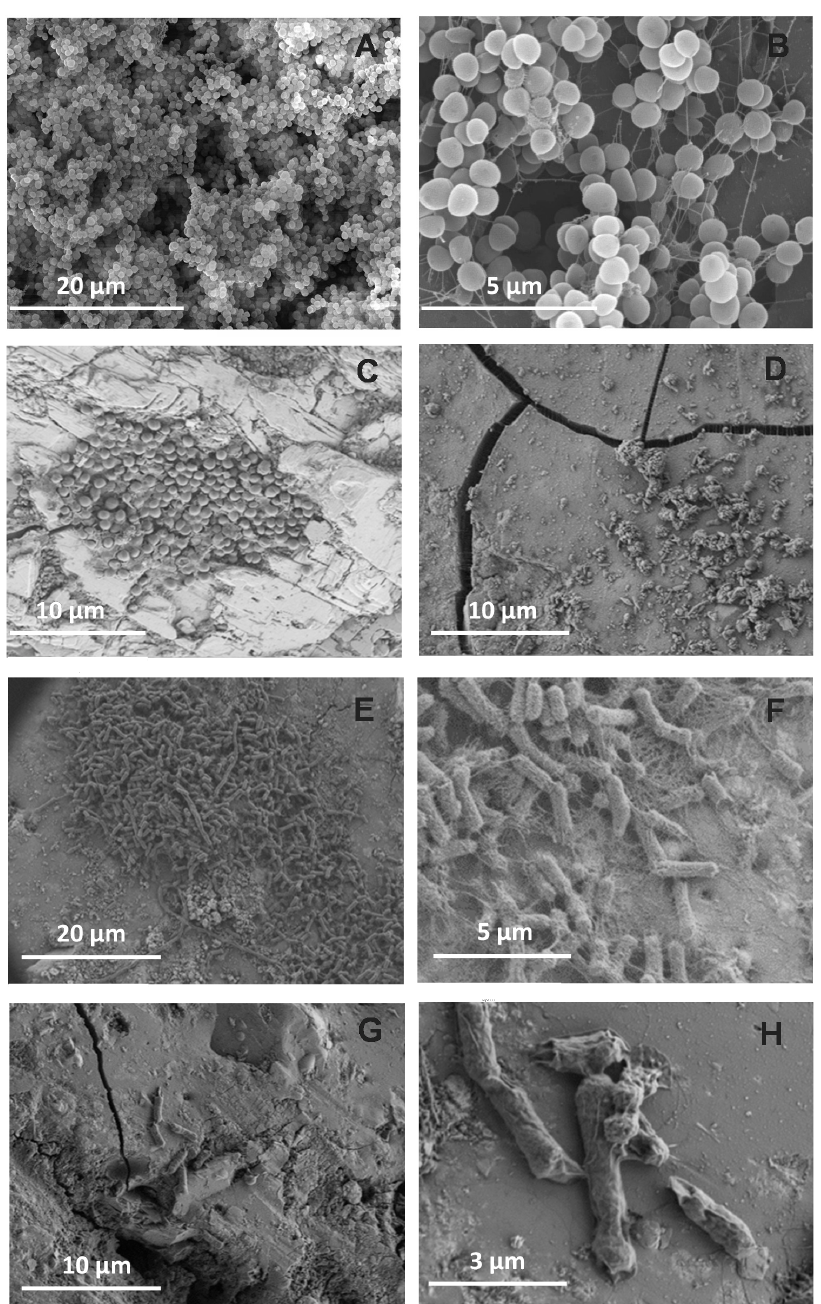
Figure 6. Scanning electron micrographs of S . epidermidis ( A – D ) and E. coli ( E – H ) grown on glass pellets. ( A , B ) panels show S. epidermidis biofilm formation on the surface of control G1 at day 5; ( C , D ) show colonization of ZnO35 pellets by S. epidermidis after 24 h ( C ) and 5 days ( D ); ( E , F ) show growth of E. coli on ZnO35 surfaces after 24 h, and ( G , H ) after 5 days. In previous studies, the cytotoxicity of these glasses was evaluated for both powders and coatings using NIH-3T cells and the viability was >80% in all cases, which implies no cytotoxicity [23,33]. Considering the results obtained in this study, we can ensure that the glass shows excellent multifunctional performances as a bactericide agent and inhibits biofilm formation without